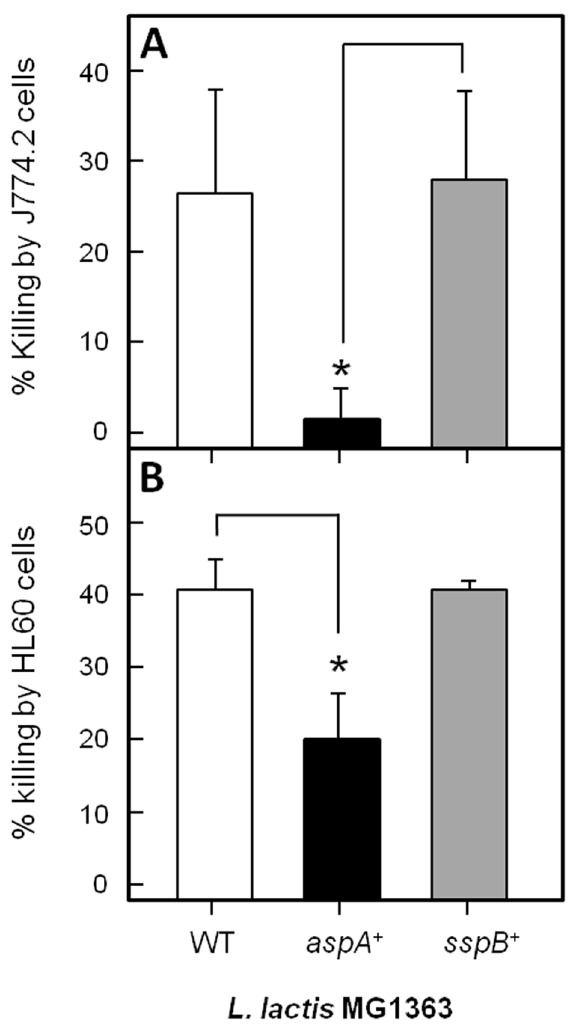
Figure 6. Percentage killing of L.lactis MG1363 wild type, and AspA or SspB expressing strains, by (A) J774.2 macrophages or (B) HL60 neutrophils following 1 h co-incubation compared with controls. Percentage killing was calculated from cfu remaining compared with control samples without macrophages or neutrophils. Data are means 6 SEM of 3 experiments repeated in triplicate. *=P , 0.05 using 2 tail student T-test.